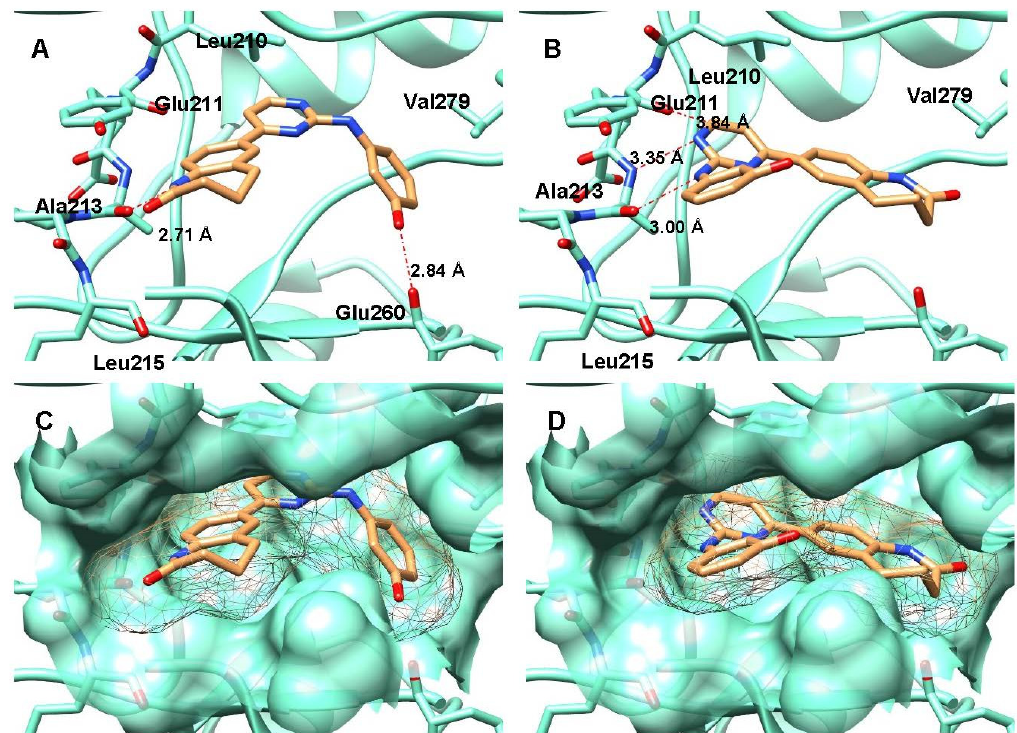
Figure 3. Two different binding modes of 2m (sand brown) in the ATP binding pocket of aurora kinase A (PDB: 2WTV, aquamarine [24]) predicted by docking experiments. Hydrogen bonds are shown in red chain lines. Left ( A , C ): Without application of constraints; right ( B , D ): constraints were defined between the nitrogen atom of the aniline partial structure of 2m and the carbonyl group of Ala213 (gk+3). ( A ): The NH of the lactam ring interacted with Ala213 (gk+3) via a hydrogen bond (D–A = 2.71 Å). In addition, a hydrogen bond (D–A = 2.84 Å) between the hydroxy group of 2m and Glu260 was predicted. ( B ): The hydrogen bond defined as constraint (D–A = 3.00 Å) was observed. Two additional hydrogen bonds were formed between the hinge region (Ala213 and Glu211) and the pyrimidine ring of 2m , involving the C(6)H group as a donor and ring nitrogen 1 as an acceptor. ( C ): Surface of the ATP-binding pocket and the ligand without constraints. The anilinopyrimidine partial structure fills the phosphate binding region. ( D ): Surface representation of the binding pocket with defined constraint. The hydroxy group was directed towards the solvent, while the benzazepine-2-one partial structure filled the hydrophobic region and the phosphate binding region.